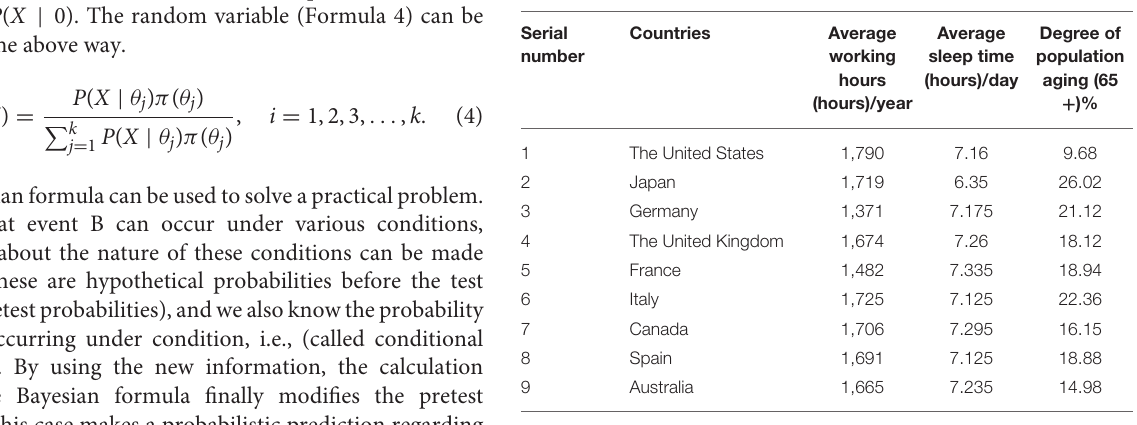
TABLE 3 | Indices and data related to sleep habits.